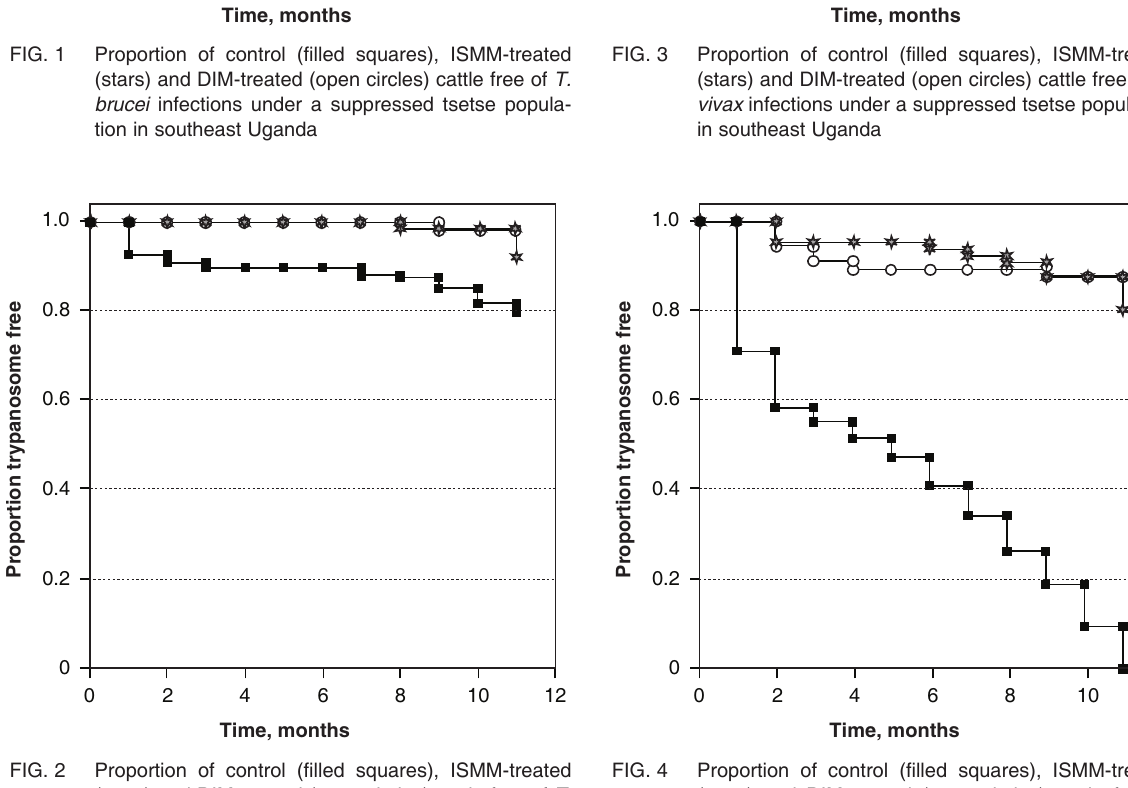
FIG. 4 Proportion of control (filled squares), ISMM-treated (stars) and DIM-treated (open circles) cattle free of infections with any trypanosome species under a sup- pressed tsetse population in southeast